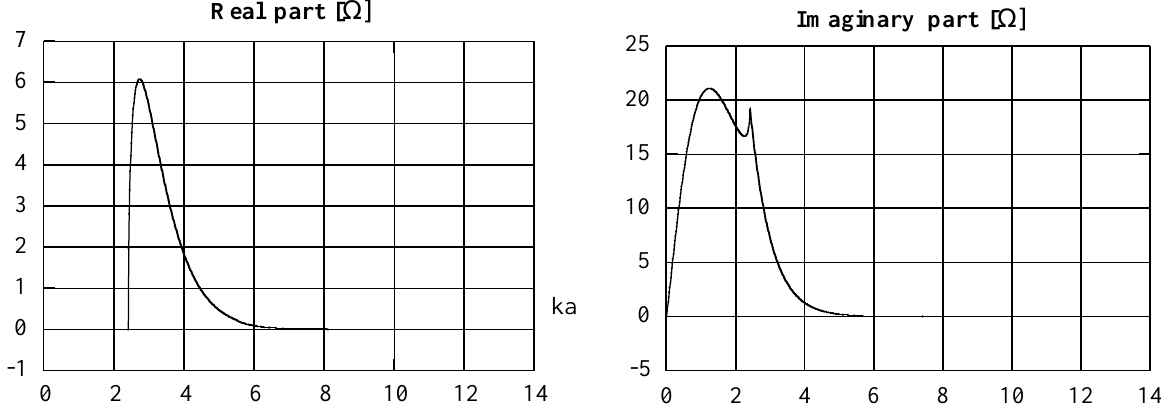
FIG. 11. Real and imaginary parts of the longitudinal coupling impedance in the case (cid:119) (cid:173) (cid:51) (cid:121) (cid:53) and bg (cid:173) (cid:49) .